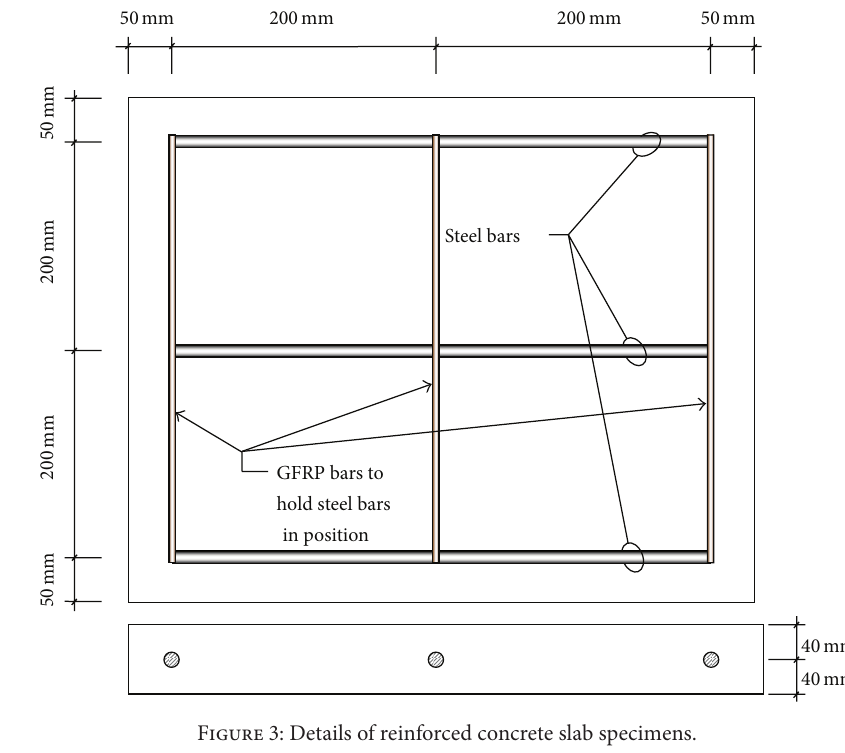
Figure 3: Details of reinforced concrete slab specimens.